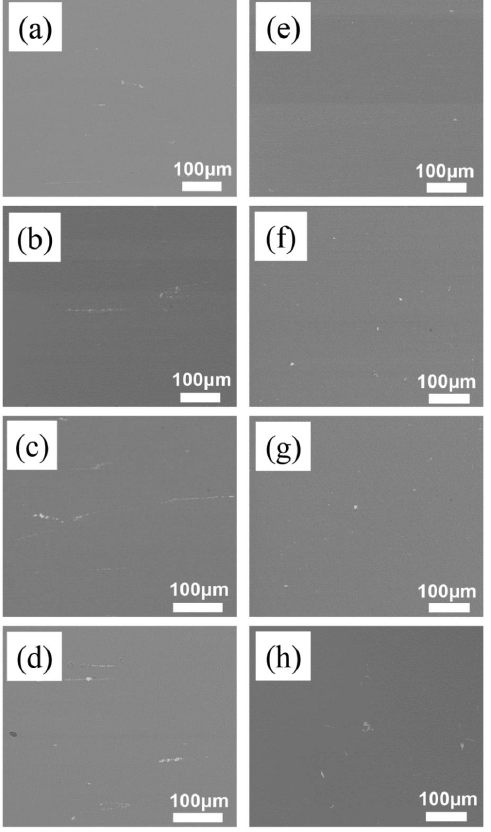
Figure 3. SEM images of the alloys with different Cu contents: ( a , e ) 0.98 wt.%Cu; ( b , f ) 1.45 wt.%Cu; ( c , g ) 1.69 wt.%Cu; ( d , h ) 2.02 wt.%Cu; L-T: ( a – d ); S-T: ( e – h